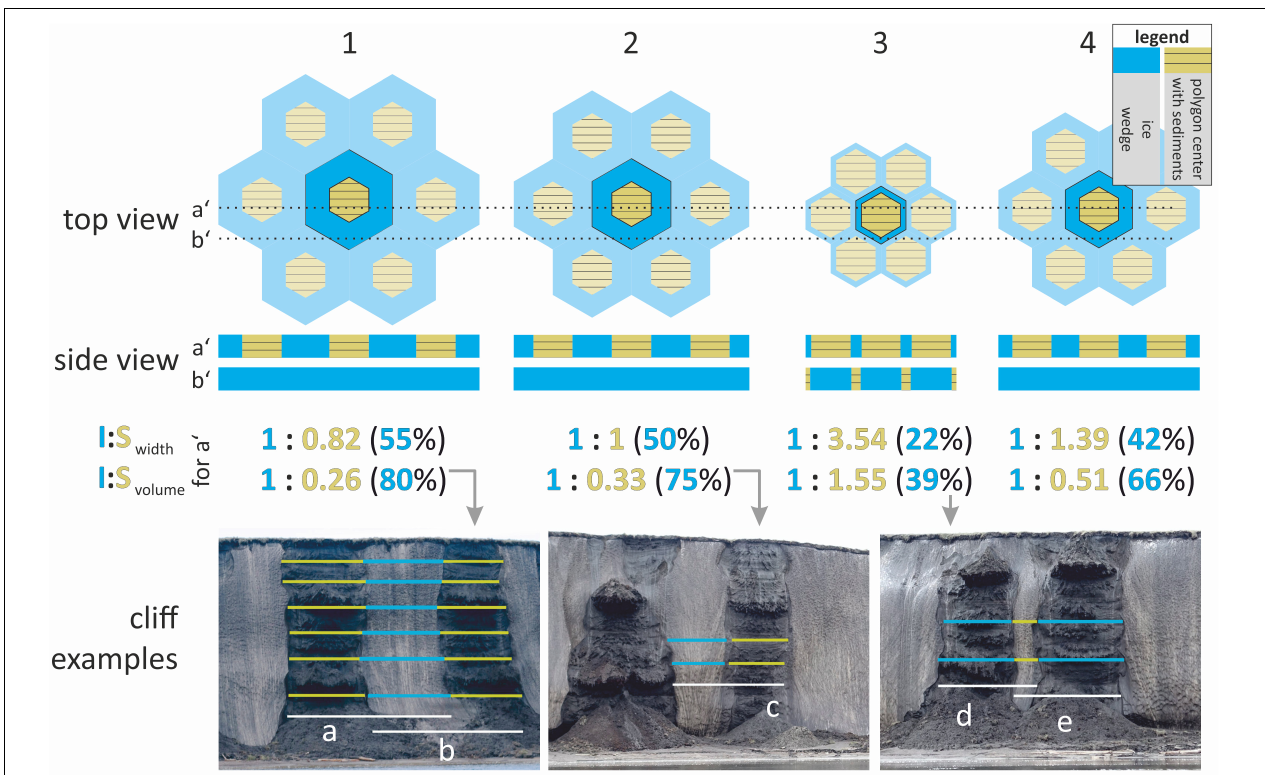
FIGURE 2 | Quantification of ice wedge to sediment ratio for the yedoma exposed at Sobo-Sise Cliff. Top view shows an ideal distribution of polygons in the landscape, where inner polygons (sediment, yellow) are surrounded by ice wedge containing outer polygons (blue). In the panels 1–3, the size of ice wedges is declining from left (1) to right (3), whereas column 1 shows the maximum width of ice wedges at Sobo-Sise Cliff; column 2 shows an equal ice to sediment ratio (1:1) and column 3 shows the minimum ice wedge width at Sobo-Sise Cliff. Column 4 shows the calculated average ice wedge content at Sobo-Sise Cliff (no cliff example photograph). The side view (or cliff view) shows a cross section of the polygons where profile a (cid:48) indicates an ideal cross section cutting the polygon centers at true width (leading to sediment sections which dissect the entire Sobo-Sise Cliff from top to bottom), whereas b (cid:48) shows a cross section with masked polygon centers leading to an ice-dominated cliff wall. The I:S width (width ice: width sediment) was determined based on photographs from the cliff front visible in the lowermost cliff example panels according to the sections a–e. The percentage in brackets indicates the relation between the width of the ice wedge in relation to the width of the sediment section. This allowed calculating the I:S volume (volume outer polygon: volume inner polygon) at the Sobo-Sise Cliff according to Eqs 1–3 and in a final step the ice wedge content (blue numbers in percentage). The cliff examples show three photographs with typical side views of the Sobo-Sise Cliff which match the top and side view of columns 1, 2, and 3 (photographs by T. Opel (left) and A. Fricke (middle and right). The lower case letters a–e indicate the analyzed I:S width across difference depths of the Sobo-Sise Cliff. More details on the analyzed sections are given in the Supplementary Table S1 and Supplementary Figure S4 . The average ice wedge content at Sobo-Sise Cliff is 66 vol% with an I:S width of 1:1.39 (or 0.72). This case is shown in column no. 4.